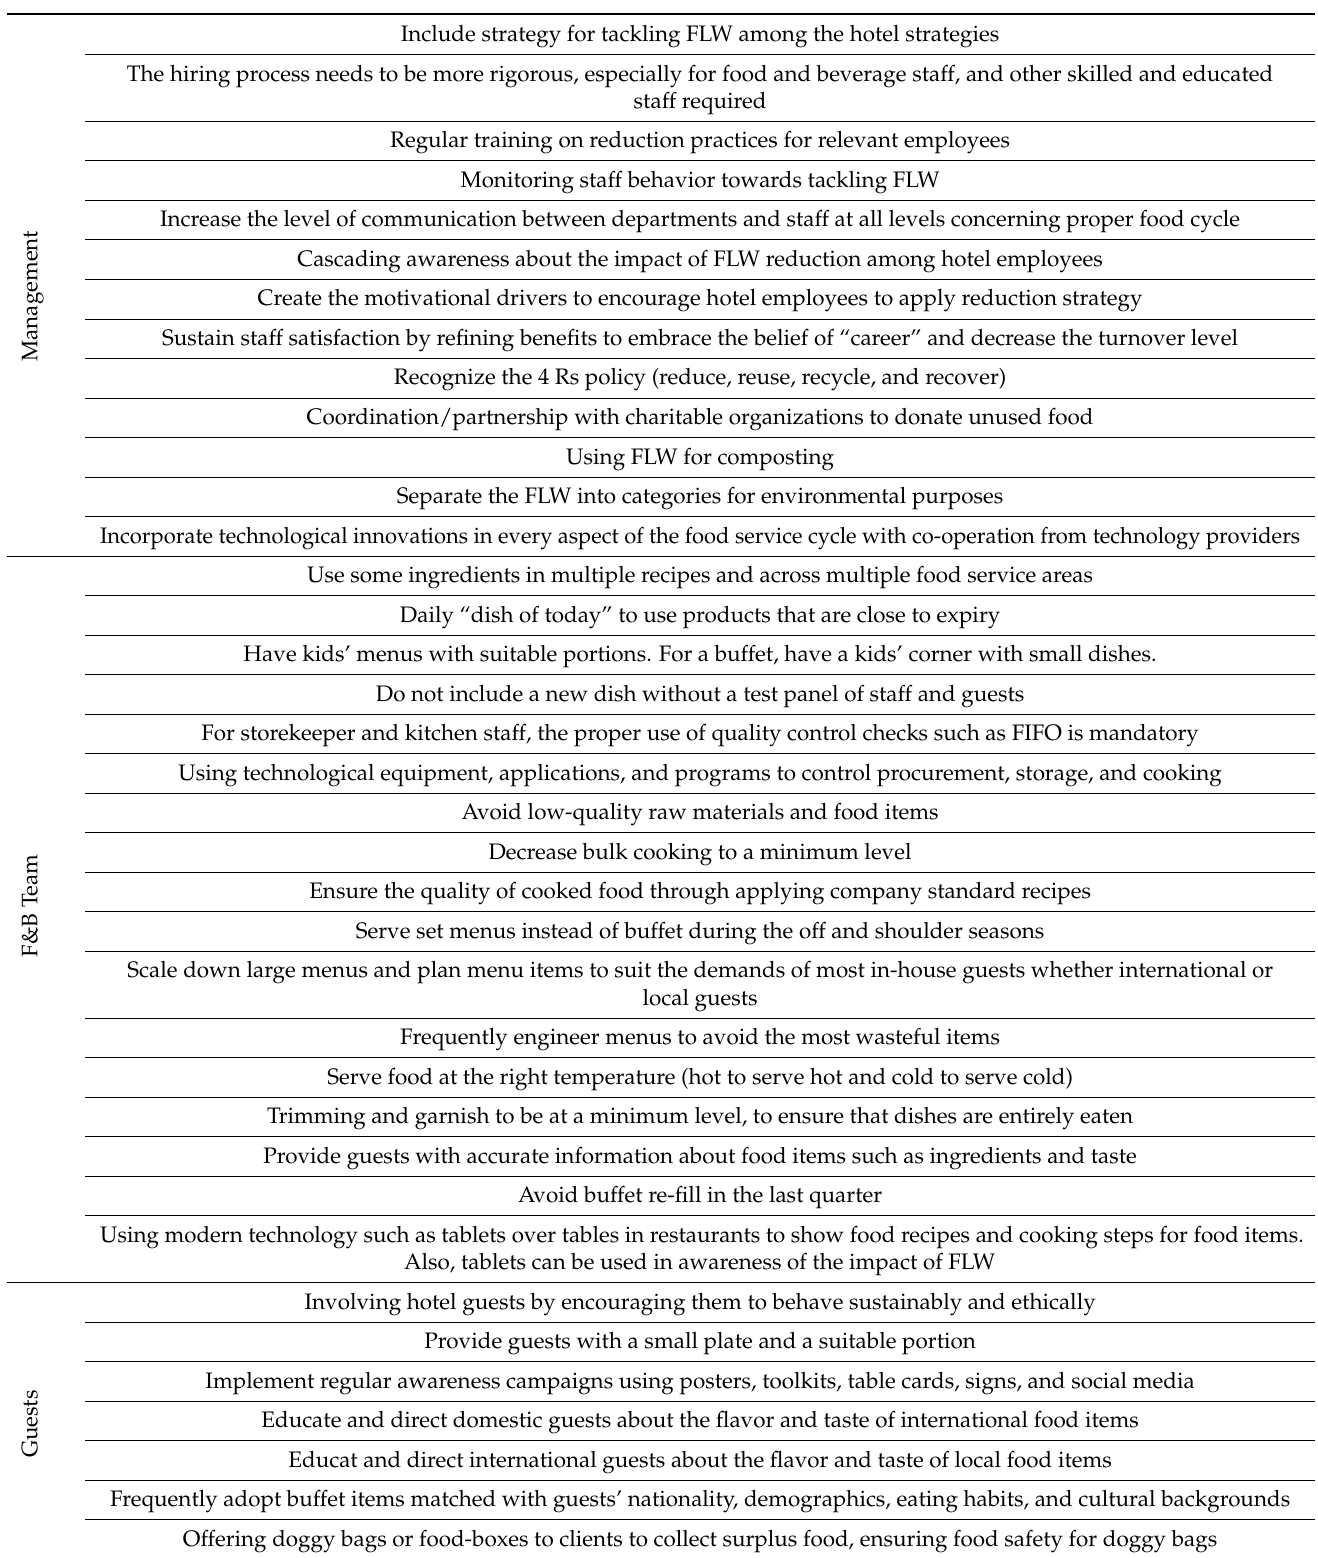
Table 4. Recommendations for tackling FLW in all-inclusive